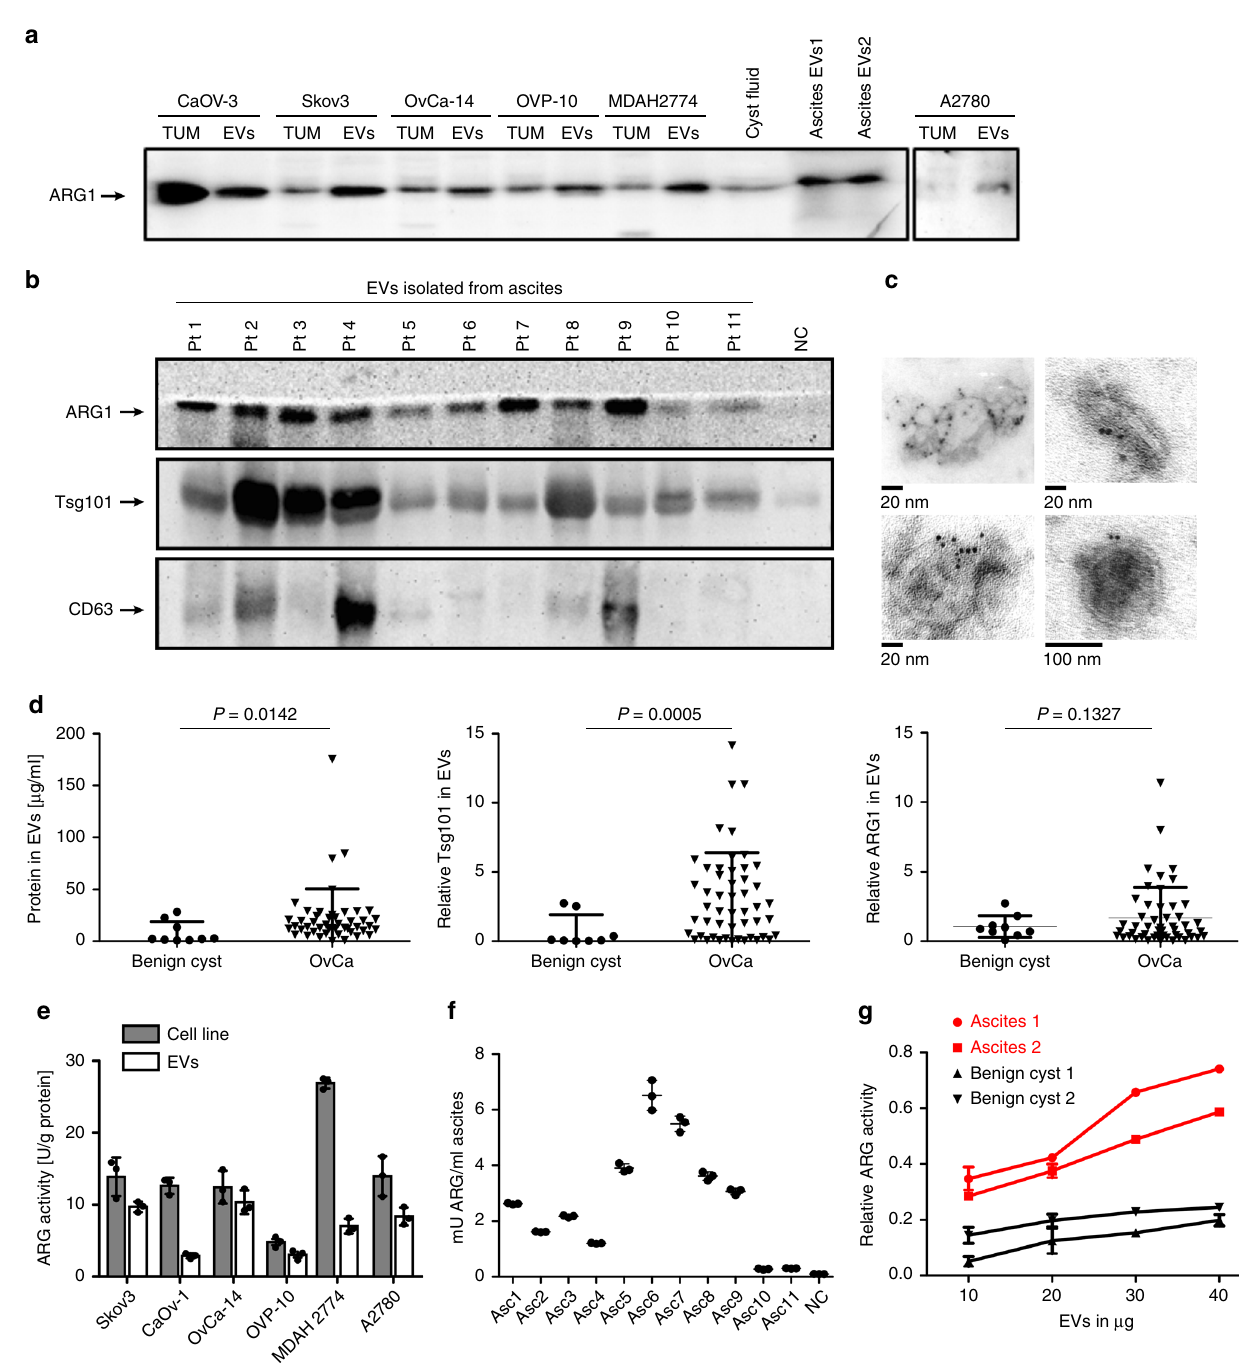
Fig. 2 OvCa-derived EVs contain enzymatically active ARG1. a ARG1 content in EVs and the parental OvCa cell lines lysates (TUM) as well as in EVs isolated from the cyst fl uid and ascites fl uid of two OvCa patients (EV1, EV2) determined by Western blotting. Equal amounts of protein (30 μ g) were loaded per lane. b Representative Western blot for ARG1 and typical exosomal markers in EVs isolated from ascites of n = 11 OvCa patients. EVs isolated from ovarian fl uid served as normal control (NC). Equal amounts of protein (30 μ g) were loaded per lane. c Representative TEM images of whole-mounted OvCa patient-derived tEVs. Dots indicate immunogold (6 nm gold particles) labeling of ARG1. d Protein concentration measured with BCA assay, Tsg101 and ARG1 levels in EVs isolated from 2 ml of ascites of OvCa patients ( n = 47 – 50) and from 2 ml of benign cysts fl uid ( n = 7 – 9). Relative Tsg101 and ARG1 content was determined by densitometric analysis of Western blots. Data refers to means± SD, P values were calculated with unpaired t -test with Welch ’ s correction. e Arginase activity in OvCa cell line lysates and in the corresponding EVs determined by measuring ʟ -arginine conversion to urea in a colorimetric assay. Data show means ± SD, n = 3. f Arginase activity in EVs isolated from n = 11 OvCa patients ’ ascites (Asc) and benign cyst fl uid (NC) calculated per ml of starting fl uid volume. Data show means± SD, n = 3. g Arginase activity as a function of amount of EVs in n = 2 OvCa patients ascites- isolated tEVs and EVs isolated from n = 2 benign cyst fl uid. Data show means ± SD. Source data for data in panels a , b , d – g are provided as a Source Data fi